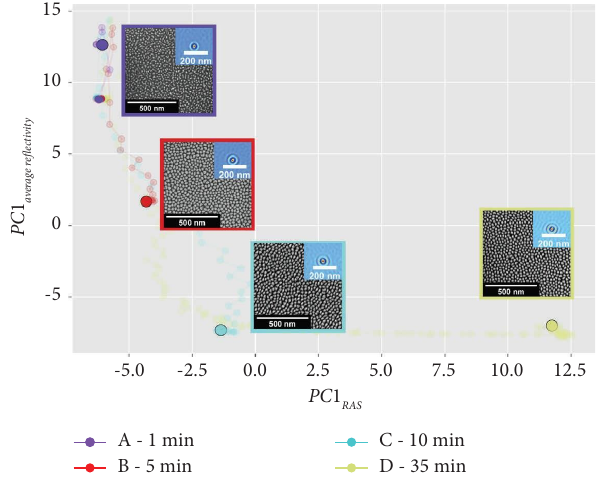
Figure 4: PC1 RAS and PC1 average refectivity evolutions and scanning electron microscope (SEM) images of “Brush Cut” morphologies introduced during reactive ion etching (RIE) of GaSb substrates. Insets in the SEM micrographs correspond to their two-dimen- sional spatial